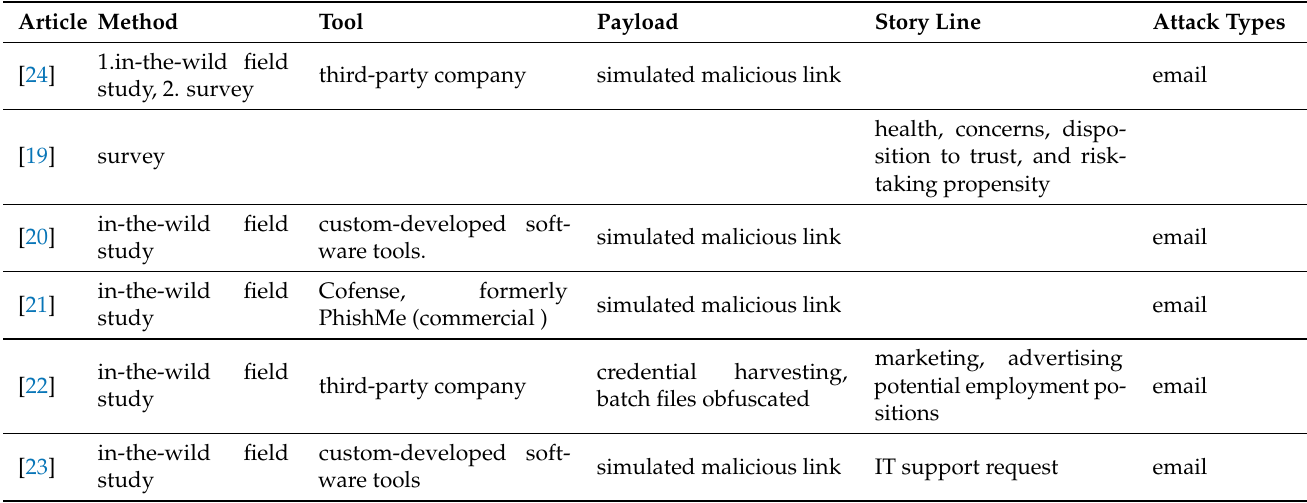
Table 2. Literature review categorization results.